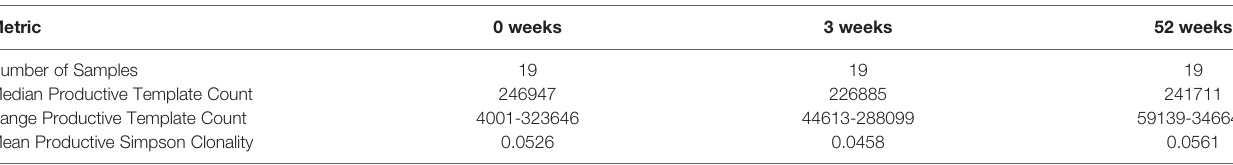
TABLE 1 | Immunosequencing Summary